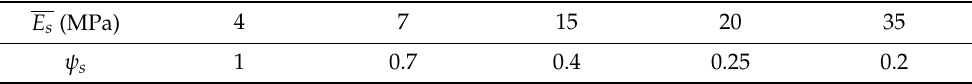
Table 1. Empirical coefficient of calculated settlement ψ s